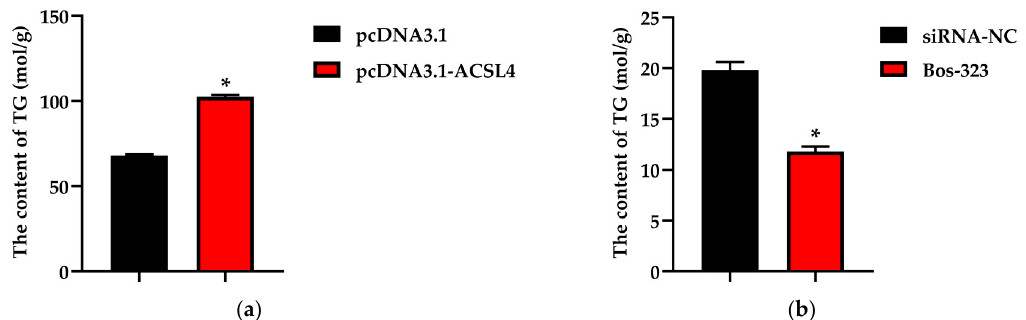
Figure 5. Triglycerides content assay in BMECs. ( a ) BMECs were transfected with pcDNA3.1-ACSL4, and the triglycerides content was determined. ( b ) BMECs were transfected with Bos-323, and the triglycerides content was determined. Values are presented as the mean ± standard errors; *, p < 0.05.